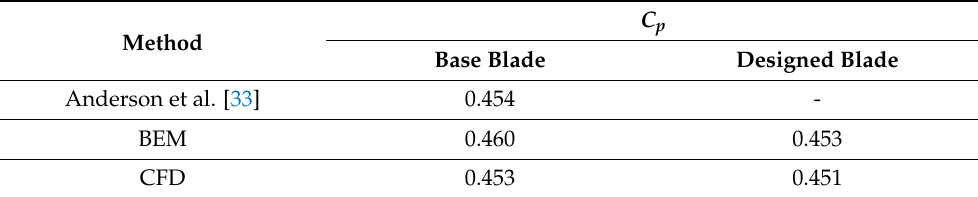
Table 3. The C p values of the base/designed blades.